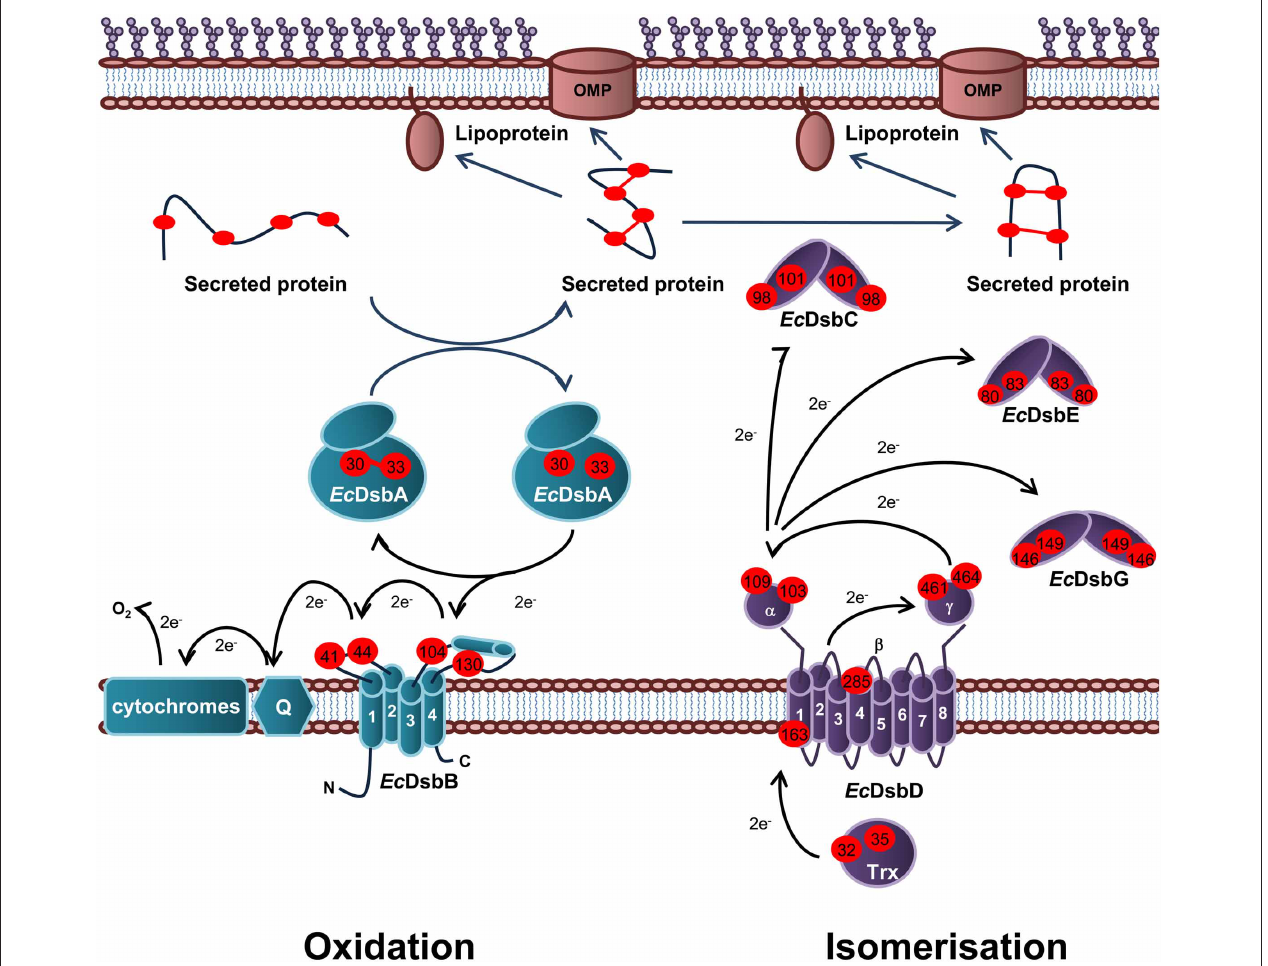
FIGURE 1 | Oxidation and isomerization pathways of periplasmic protein folding in E. coli . Oxidation pathway: The soluble oxidoreductase Ec DsbA catalyses disulfide bond formation between adjacent cysteine residues of secreted proteins. Ec DsbA is re-oxidized by the IM bound Ec DsbB. Under aerobic growth conditions, electrons flow from Ec DsbB to molecular oxygen via ubiquinone (Q) and cytochrome. Isomerization pathway: The oxidoreductase Ec DsbC re-shuffles any incorrect disulfide bonds which is important in secreted proteins that